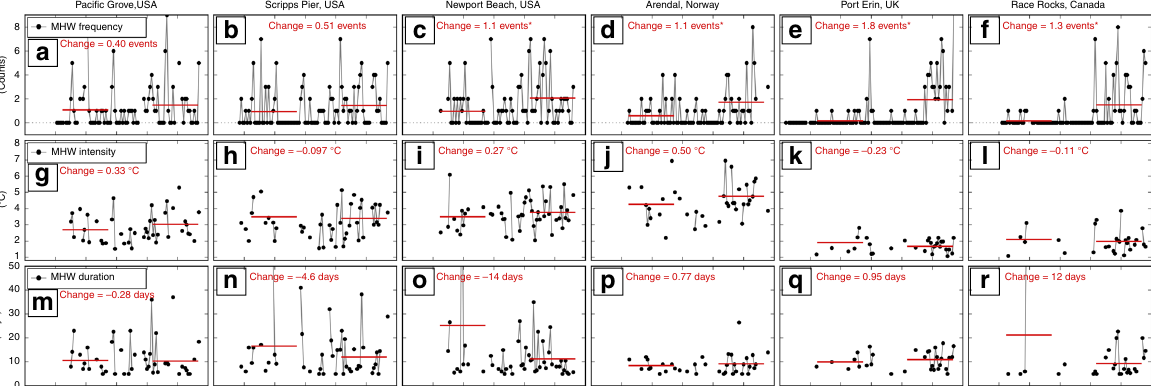
Fig. 4 Marine heatwave properties at six sites with century-long daily in situ temperature records. Shown are a – f the number of marine heatwaves (MHW) in each year, g – l average annual MHW intensity, m – r average annual MHW duration at Paci fi c Grove, Scripps Pier, Newport Beach (USA), Arendal (Norway), Port Erin (UK) and Race Rocks (Canada). Red lines show means over 1925 – 1954 and 1984 – 2013 and red text indicates differences between these periods (a star indicates statistical signi fi cance at the 5% level)